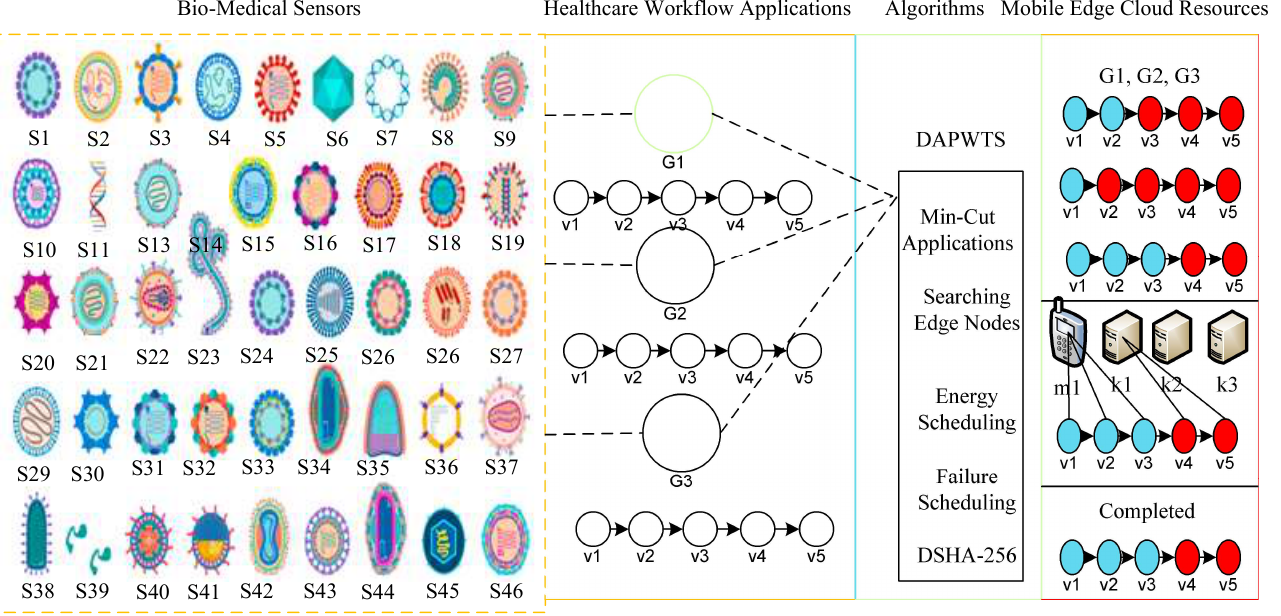
Figure 1. Biosensor-enabled mobile edge-cloud architecture: